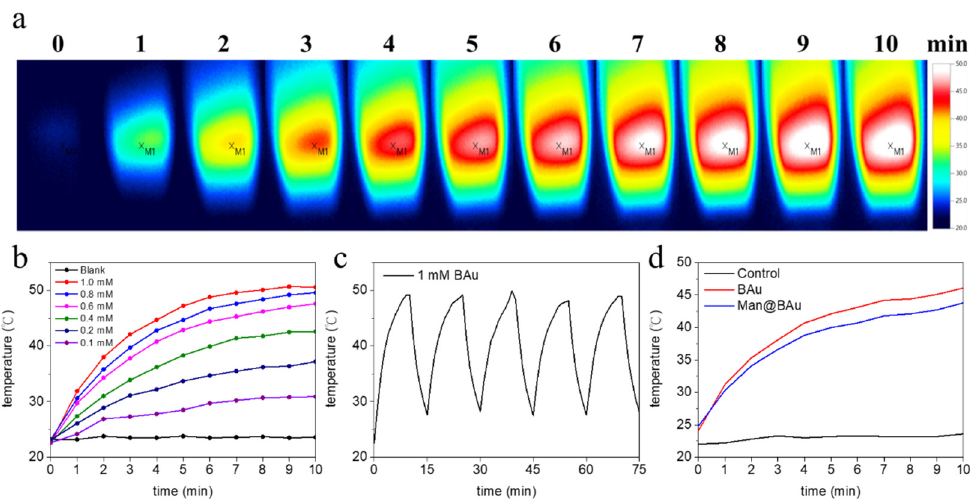
Figure 3. ( a ) Thermal-change images of 1 mM BAu NPs (2 mL) in cuvette using 808 nm laser for 10 minutes. ( b ) Photothermal effects of BAu NPs at various concentrations under same conditions as